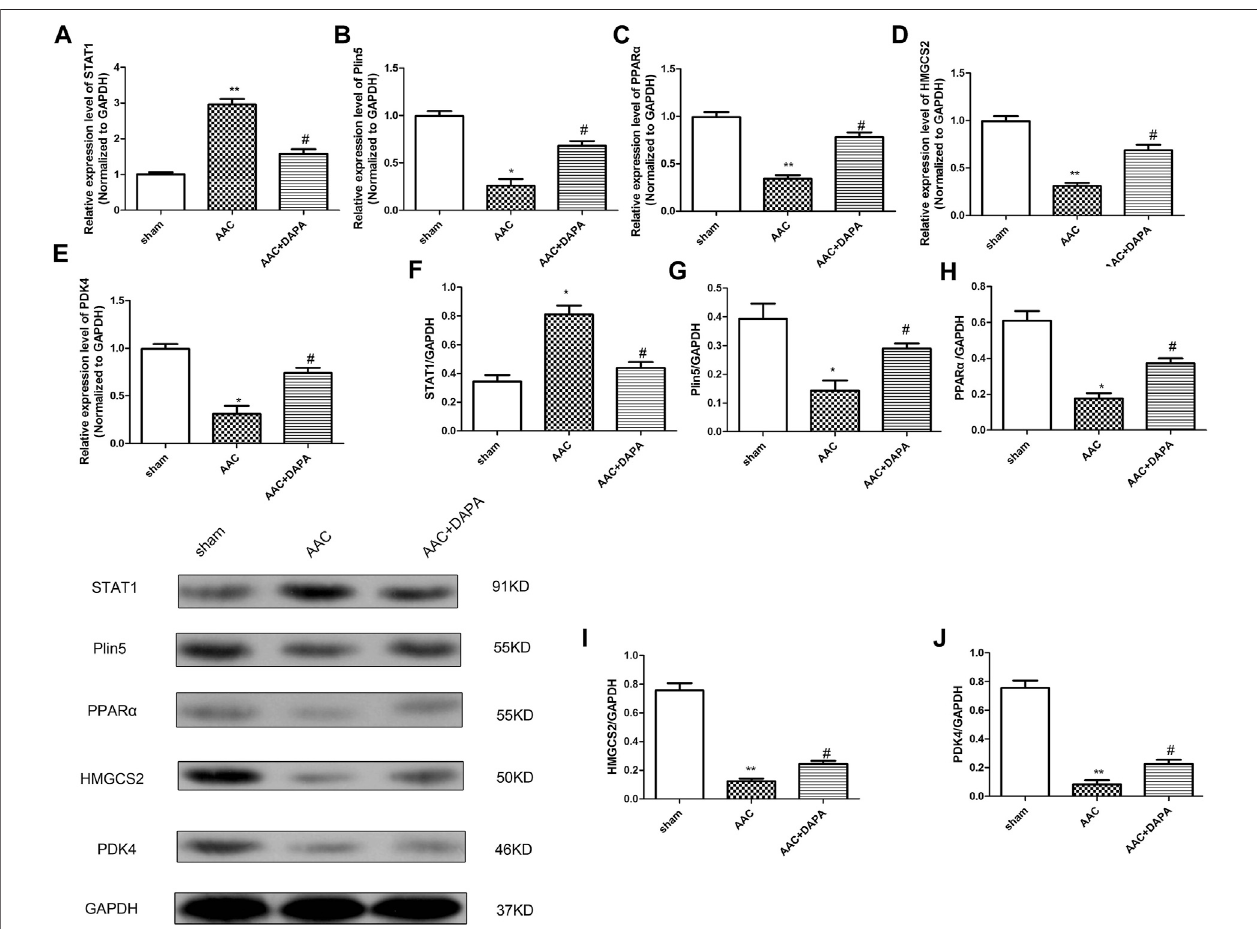
FIGURE 6 | Dapagli fl ozin mediated the Plin5/PPAR α signaling axis to attenuate cardiac hypertrophy in vivo . qRT-PCR analysis was used to detect the mRNA expressions of STAT1 (A) , Plin5 (B) , PPAR α (C) , HMGCS2 (D) and PDK4 (E) in cardiac tissues. (E) Western blotting assay was performed to detect the protein expressions of STAT1, Plin5, PPAR α , HMGCS2 and PDK4. The data were expressed as mean ± SD, n (cid:1) 3, * p < 0.05, vs. sham group; # p < 0.05, vs. AAC group.